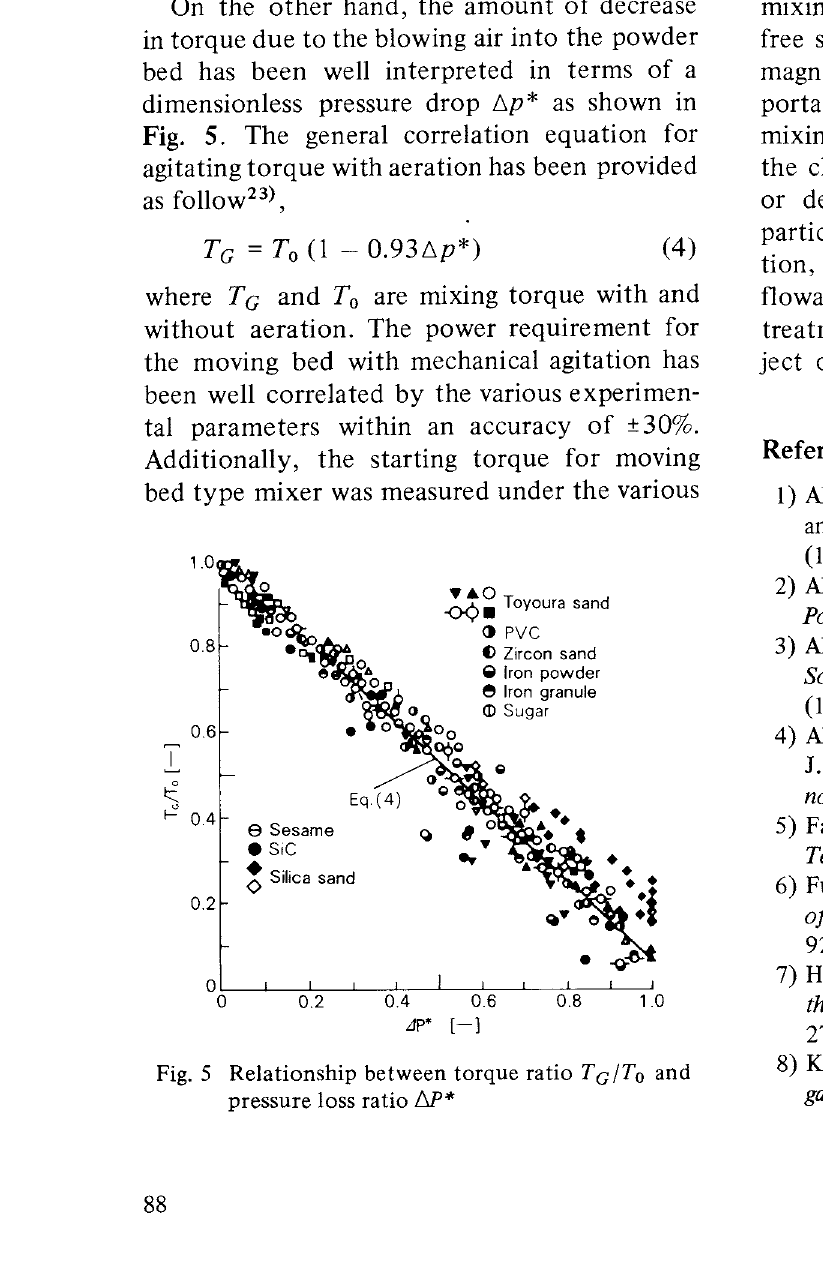
Fig. 5 Relationship between torque ratio T c /To and pressure loss